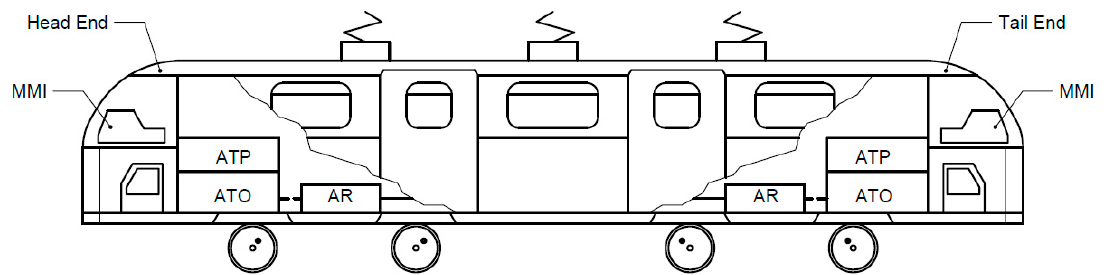
Figure 3. Schematic diagram of urban rail train interior.